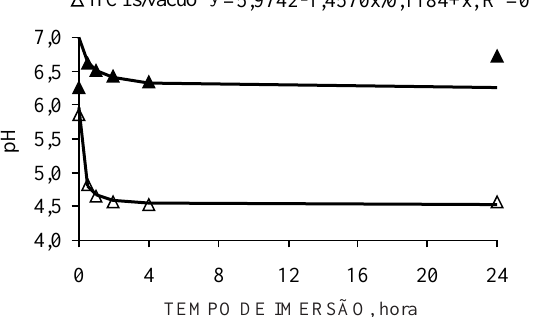
Figura 4. pH da água de imersão das cápsulas tratadas com HCl 0,1 mol L -1 mais 45 min em água destilada e deionizada, considerando o tempo de imersão.